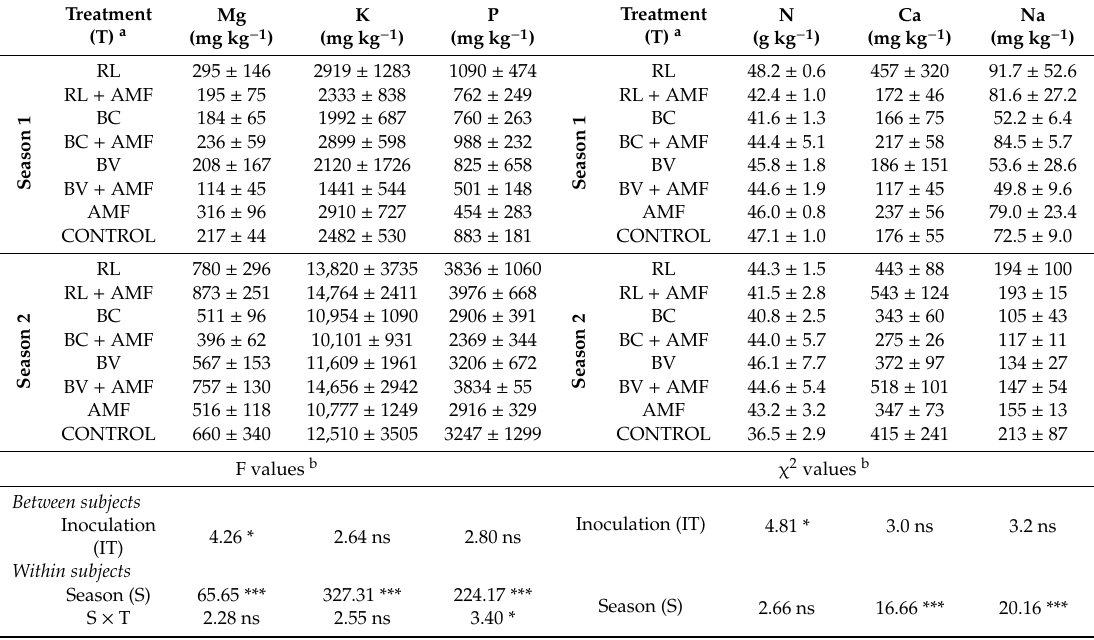
Table 2. Nutrient content of fava bean seeds in two seasons (nitrogen content, calcium, magnesium, sodium, potassium and phosphorus). Values are mean ± standard deviation ( n = 4).